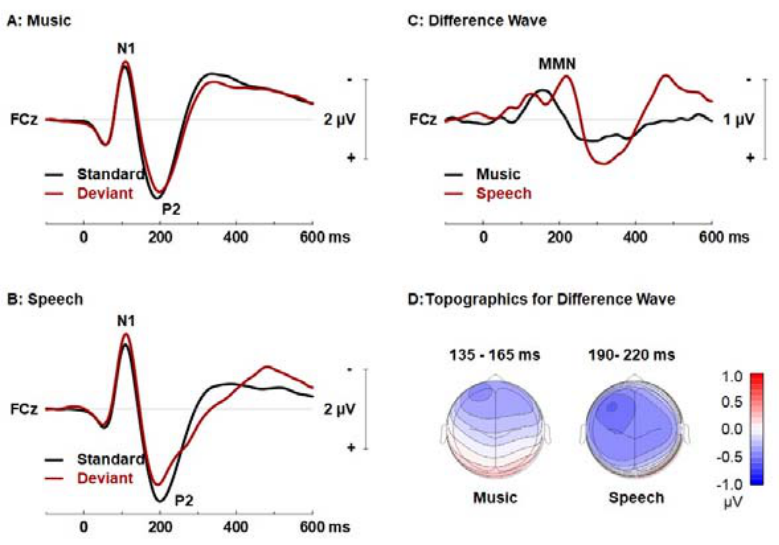
Figure 2. Pooled group mean auditory evoked responses elicited by the standard and deviant sounds in the music ( A ) and speech ( B ) oddball paradigms at pre-test. The difference waves used to isolate the mismatch negativity (MMN) are shown on the panel ( C , D ) Isocontour maps showing the MMN mean amplitude distribution for a 30 ms interval. FCz = frontocentral electrode. Table 2. Results from the clustered ‐ statistic comparing auditory evoked responses elicited by devi ‐ ant and standard stimuli from the music and speech oddball paradigm before the intervention.